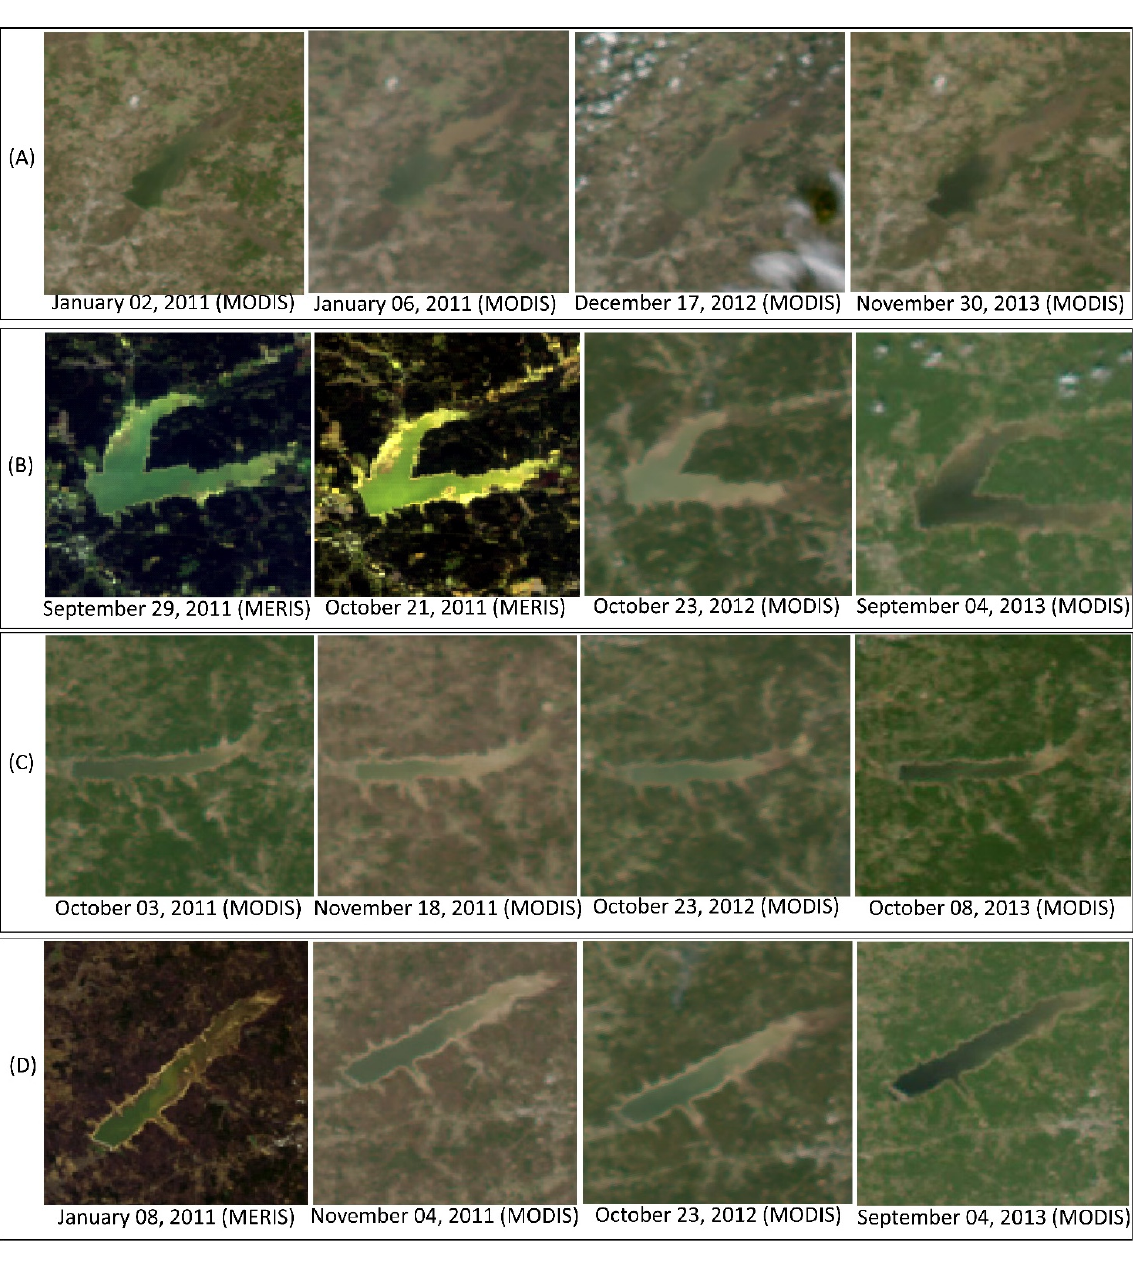
Figure 3. True color satellite images showing ( A ) Ross Barnett Reservoir and Lakes; ( B ) Grenada; ( C ) Enid; and ( D ) Sardis. Greenness in these images indicates algal blooms. Images are not to